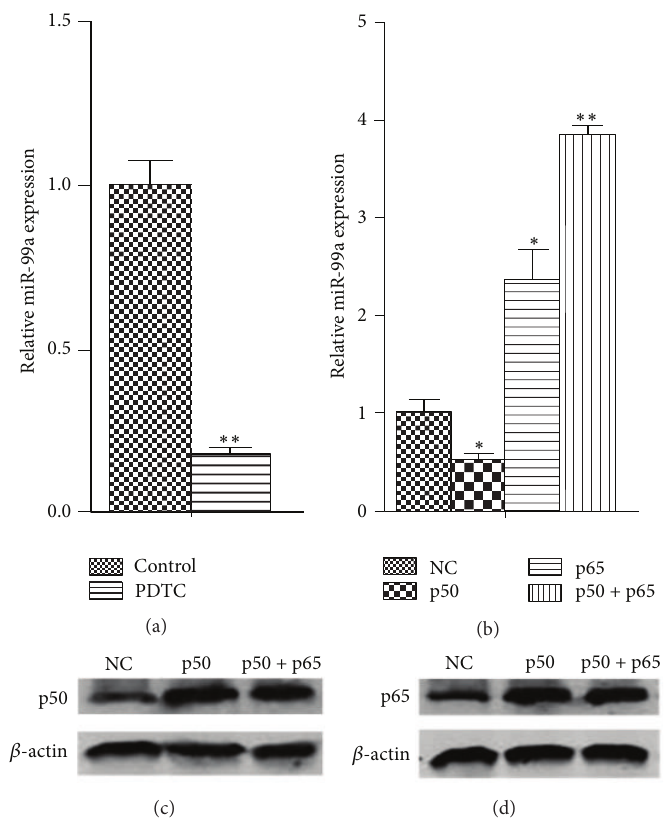
Figure 3: Regulatory effects of NF- 𝜅 B on miR-99a expression in HUVECs. ((a), (b)) Relative miR-99a expression in HUVECs after NF- 𝜅 B overexpression or inhibition. ((c), (d)) The increased p50 or p65 protein levels in HUVECs which were transfected with 4 𝜇 g of NF- 𝜅 B subunit ORF cDNA Clones (p50, p65, or p50 + p65) in 6-well plate for 48 hours. The values (mean ± SD from three independent experiments) are relative to NC or control, which was set as 1. ∗ 𝑃 < 0.05 ; ∗∗ 𝑃 < 0.01 versus NC